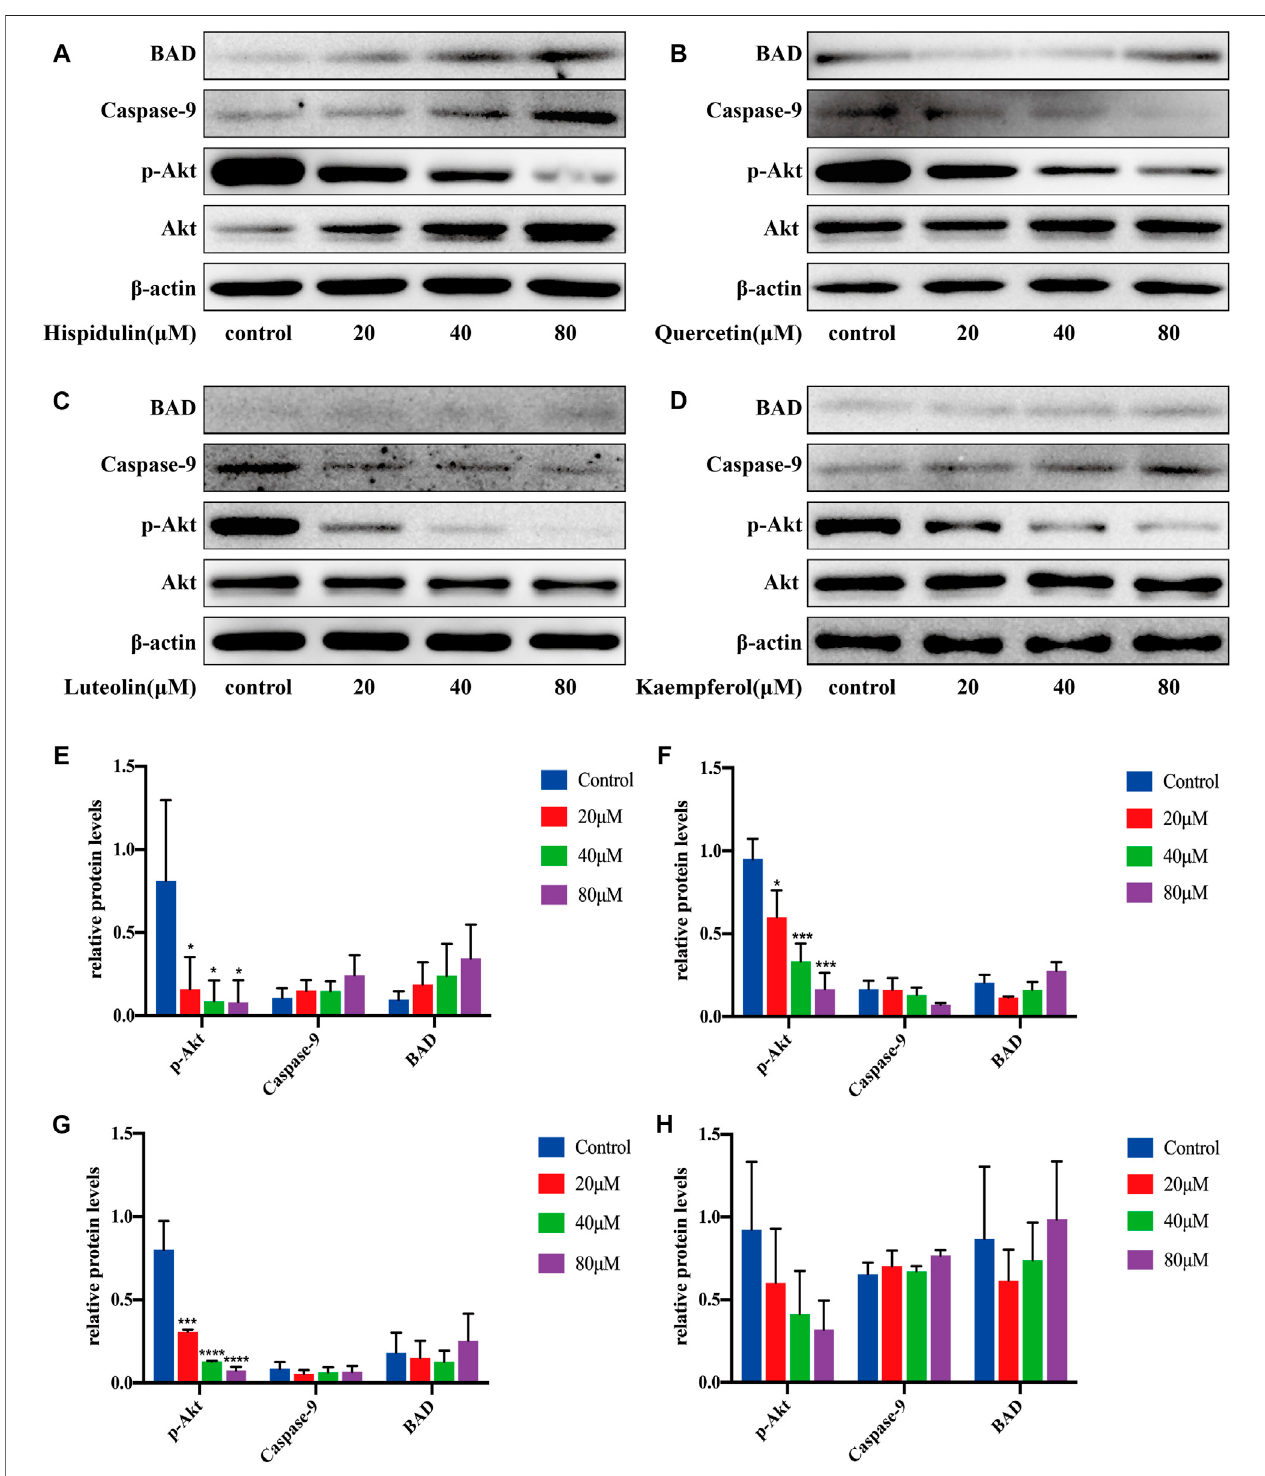
FIGURE9| WesternblotanalysisofAkt,p-Akt,caspase-9,andBADexpressionsinPC-3cells. (A) Cellsweretreatedwithorwithouthispidulin(0,20,40,or80 μ M) for 24 h. (B) Cells were treated with or without quercetin (0, 20, 40, or 80 μ M) for 24 h. (C) Cells were treated with or without luteolin (0, 20, 40, or 80 μ M) for 24 h. (D) Cells were treated with or without kaempferol (0, 20, 40, or 80 μ M) for 24 h. (E) Quanti fi cation data of western blot in group A. (F) Quanti fi cation data of western blot in groupB. (G) Quanti fi cationdataofwesternblotingroupC. (H) Quanti fi cationdataofwesternblotingroupD.Experimental valuesareexpressed asmean ± SDfor each group ( n (cid:2) 3, * p < 0.05,*** p < 0.001, and **** p < 0.0001 with the control group).